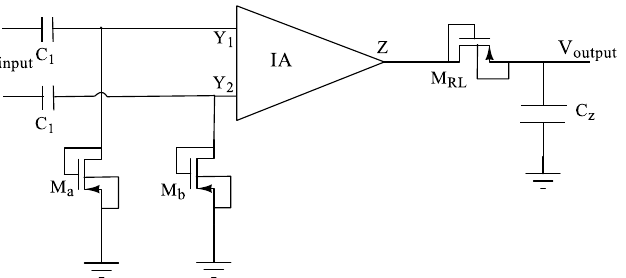
Figure 8. The schematic of the proposed configuration for separating the required frequency bands for various biomedical signals through the IA.